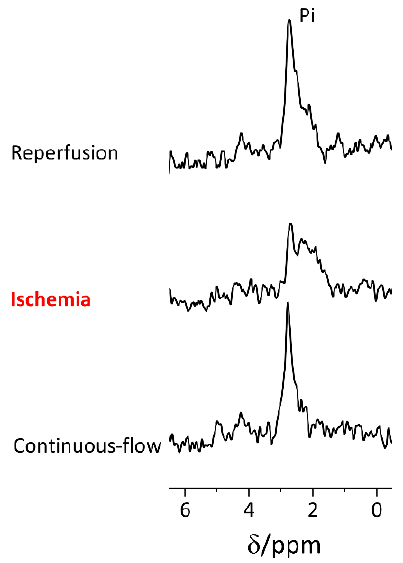
Figure 2. 31 P spectra demonstrating rapid changes in the Pi signal chemical shift and lineshape due to ischemia. The spectral region showing the Pi signal before (bottom), during (middle), and immediately following (top) the ischemic insult in a typical experiment. The Pi signal widens upon ischemia and narrows following reperfusion indicating alterations in pH. The spectra were collected over 7.6 min (412 excitations, 1.1 s repetition time, 50 ◦ nutation angle) and processed with a line-broadening of 7 Hz and zero-filling from 8192 to 16,384 points. The chemical shift was referenced to the PCr signal at − 2.5 ppm. The baseline was manually corrected. Pi—inorganic phosphate (intra- and